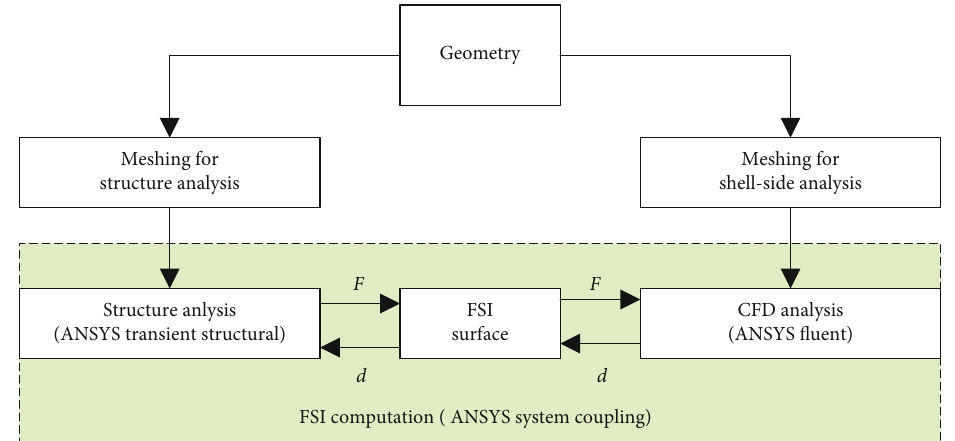
Figure 3: Schematic diagram of two-way FSC